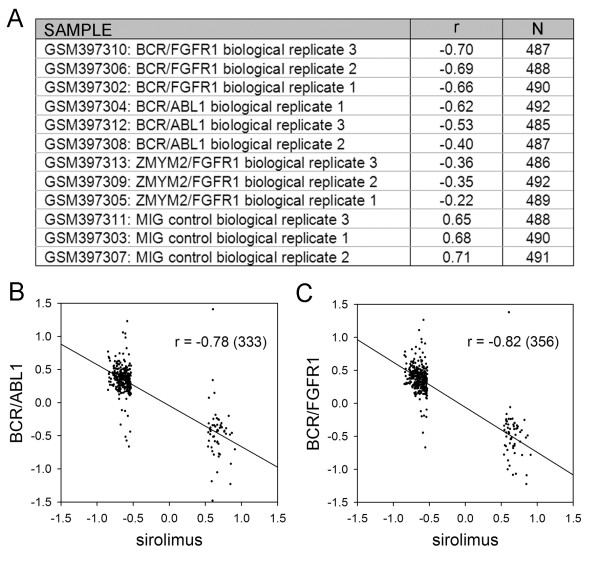
The rapamycin CMAP significantly anti-correlates with the transcriptional changes induced in chord blood cells by two distinct BCR fusion transformations. The correlations with the individual samples is shown in A and the negative regression with the pooled BCR/ABL1 transform v control and BCR/FGFR1 transform v control are shown in B and C respectively.